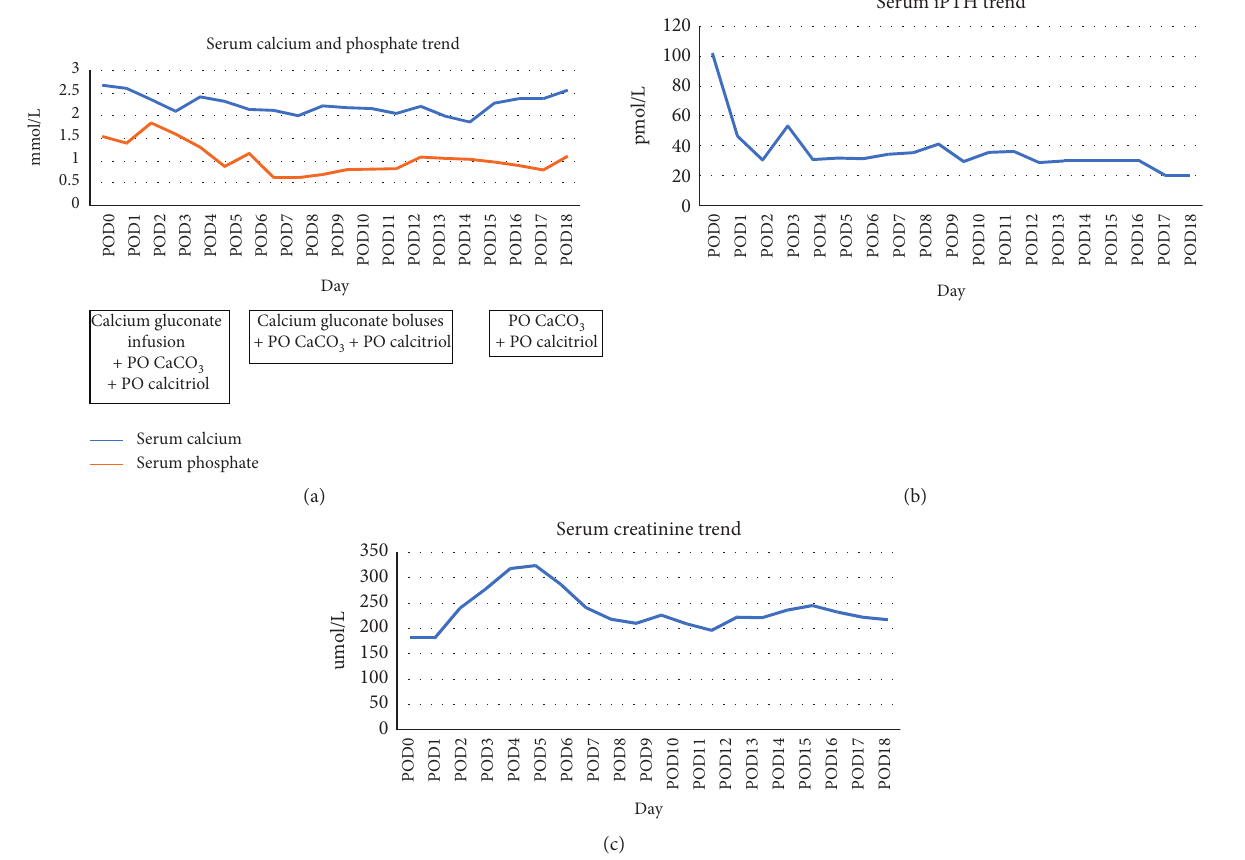
Figure 4: Laboratory trend after parathyroidectomy. (a) Serum calcium and phosphate trend. (b) Serum iPTH trend. (c) Serum creatinine